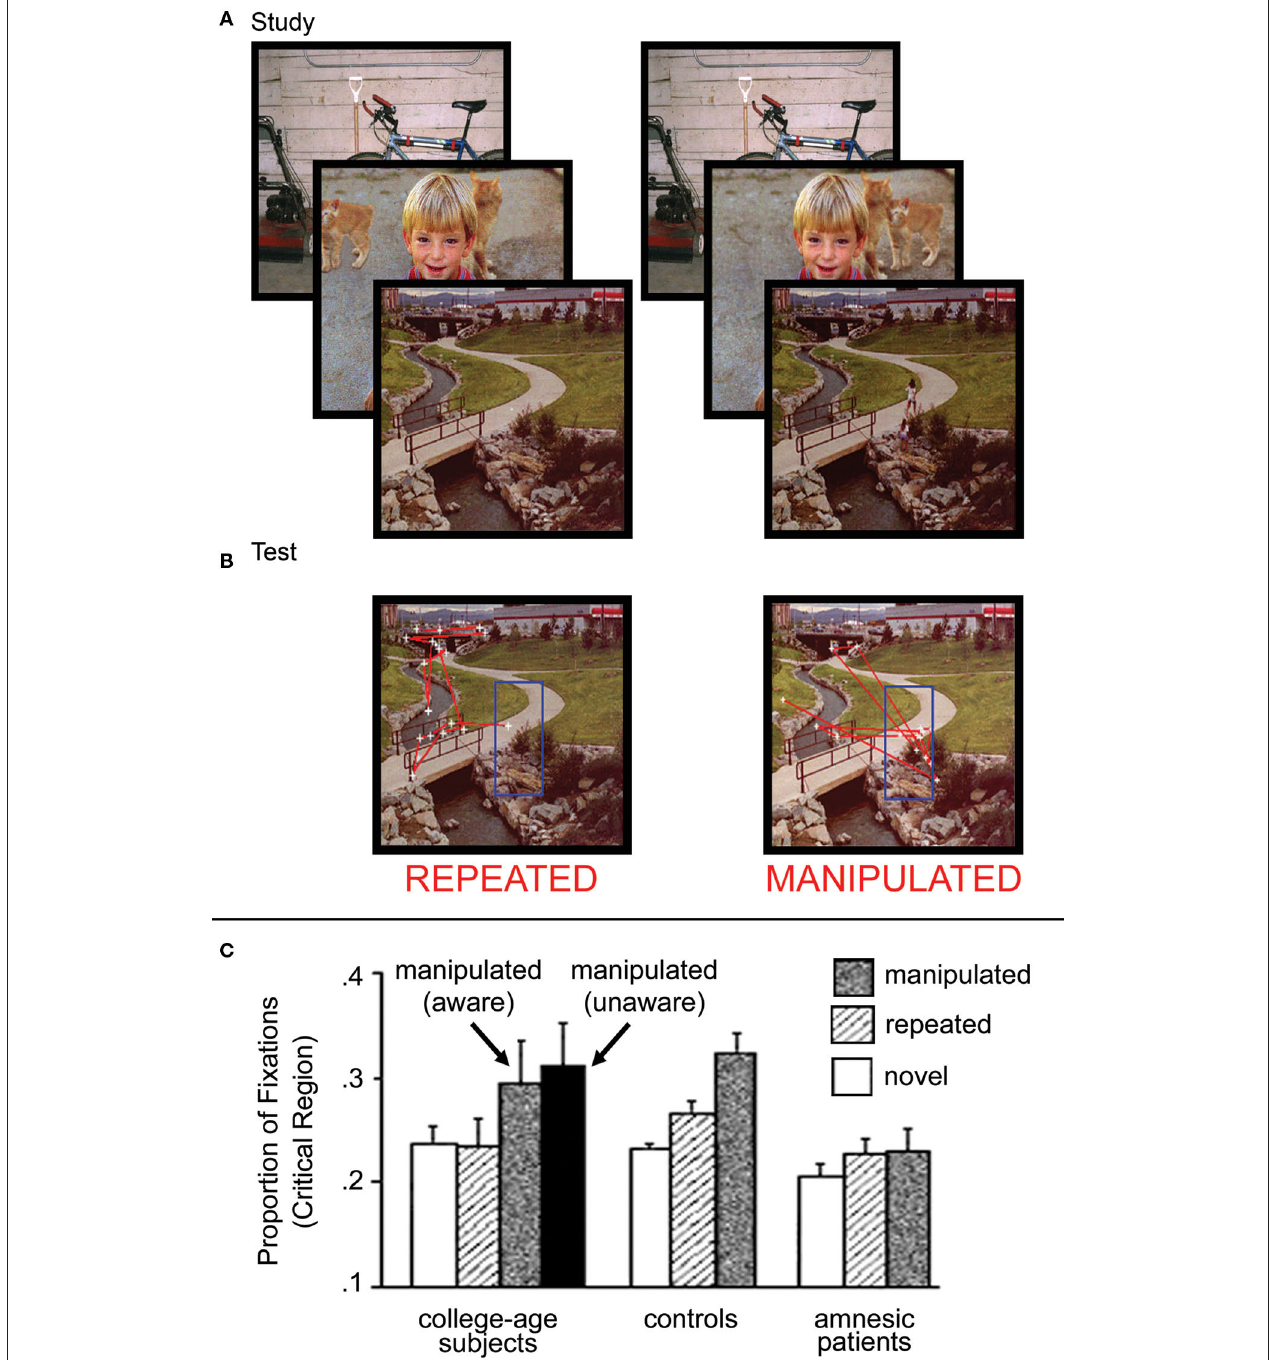
white cross hairs) are directed to, and more saccades (i.e., red lines) are made into and out of the critical region for manipulated scenes. (C) Graph illustrating the proportion of total viewing time directed to the critical regions of novel, repeated and manipulated scenes for college-age participants, neurologically intact controls, and amnesic patients. College-age participants look disproportionately at manipulated regions with or without concomitant awareness of the change. Neurologically intact controls also show this disproportionate viewing effect, which is completely absent from the viewing behavior of amnesic